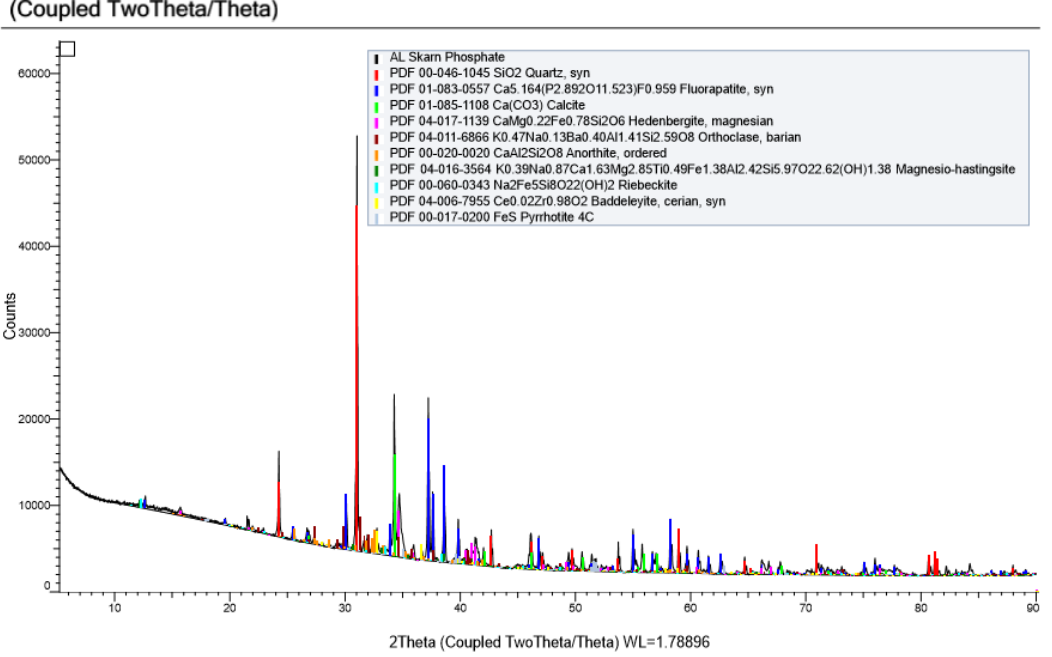
Figure 4. XRD pattern of skarn phosphate sample. The whole rock major and trace elements composition are shown in Table ?? . The Bond Work Index of the ore is found to be 19.04 kWh/t, which falls in the hard ore category of the ore hardness index [ ?